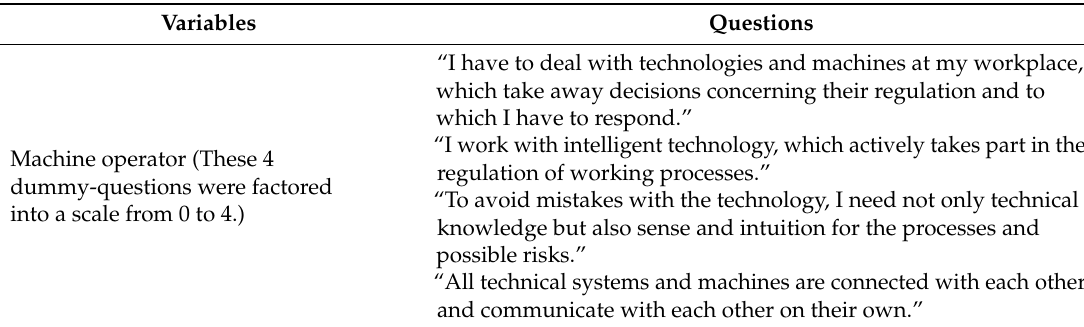
Table A1. Variable